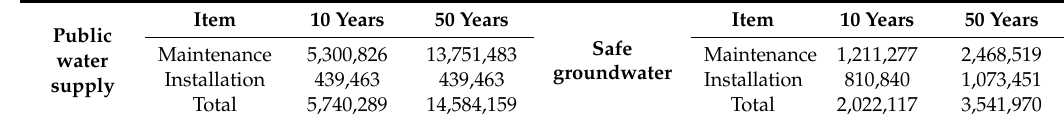
Table 14. Benefit/cost analysis of public water supply versus safe groundwater (unit: 1000